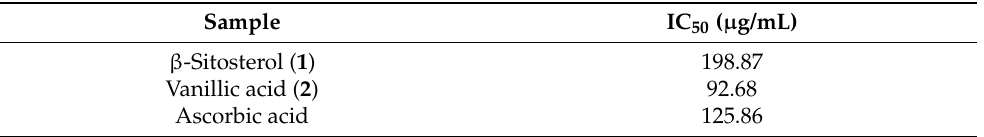
Table 1. In vitro antioxidant activity evaluation for β -sitosterol ( 1 ) and vanillic acid ( 2 ) isolated